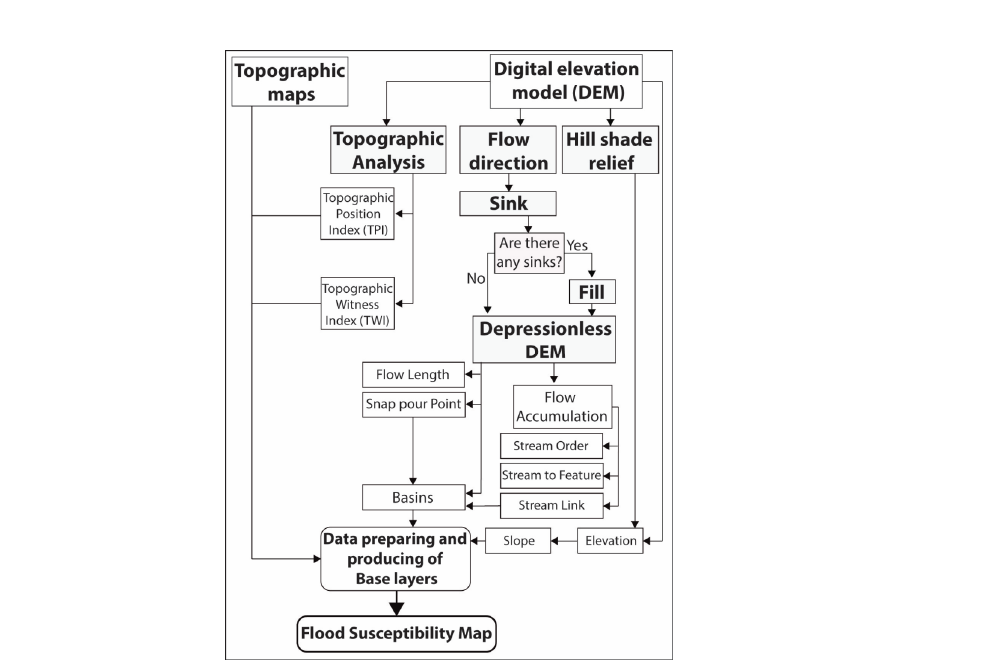
Figure 4. Methodological flow chart proposed in the study region. Table 2. Morphometric and topographic parameters.